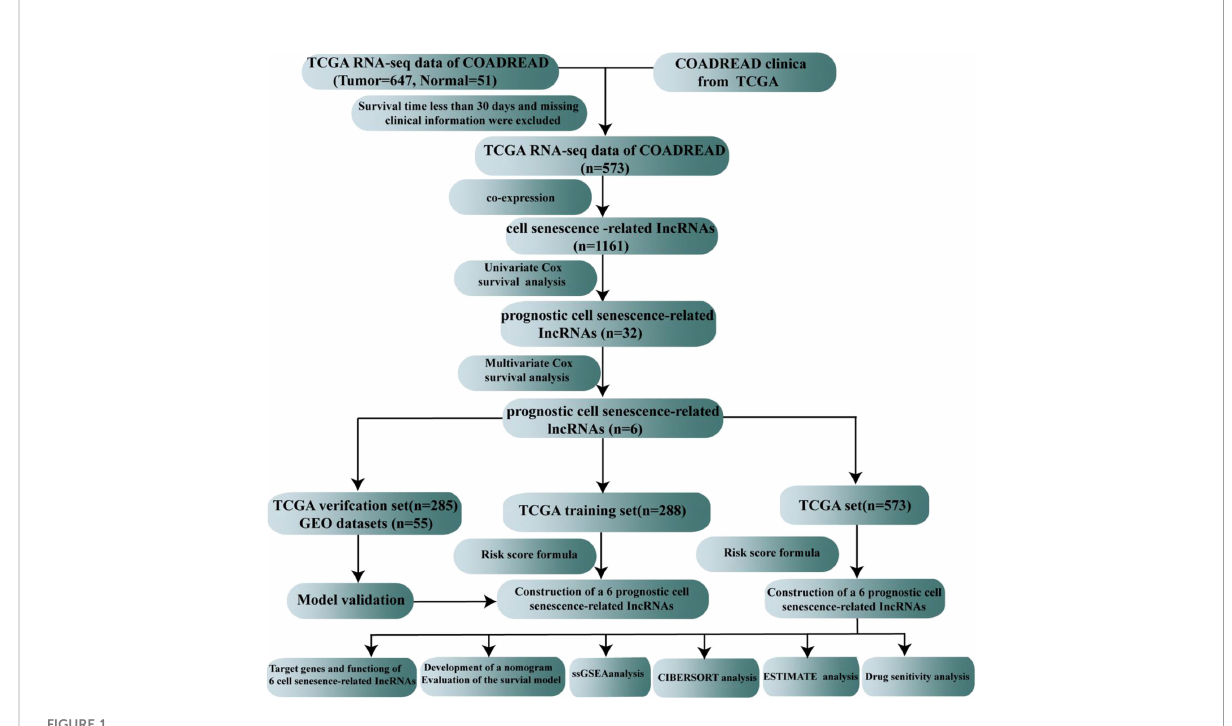
FIGURE 1 The fl ow sketch of our